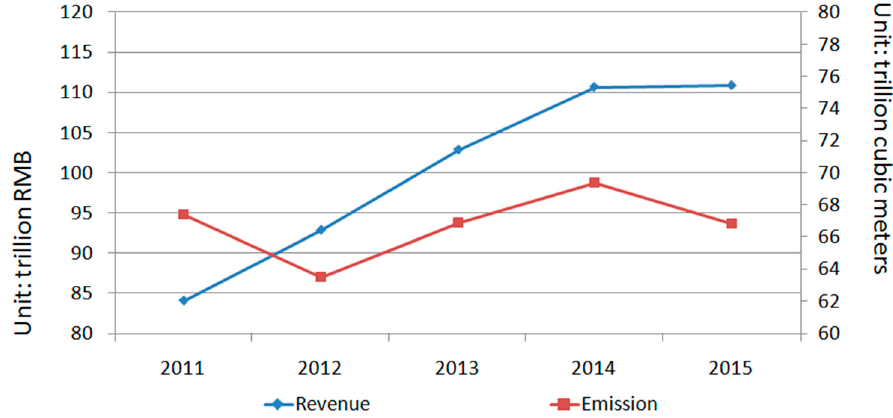
Figure 6. Trends of revenue and emission from 2011–2015.